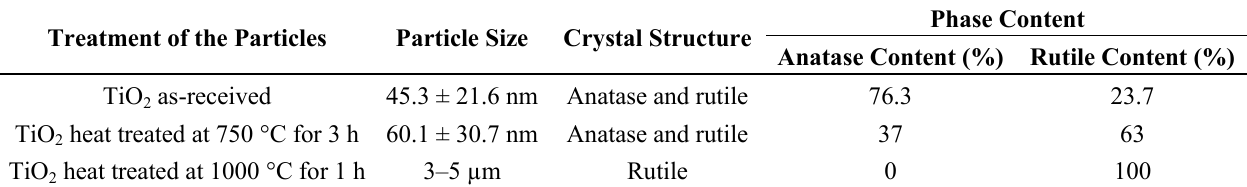
particles in as-received and heat treated conditions. 2